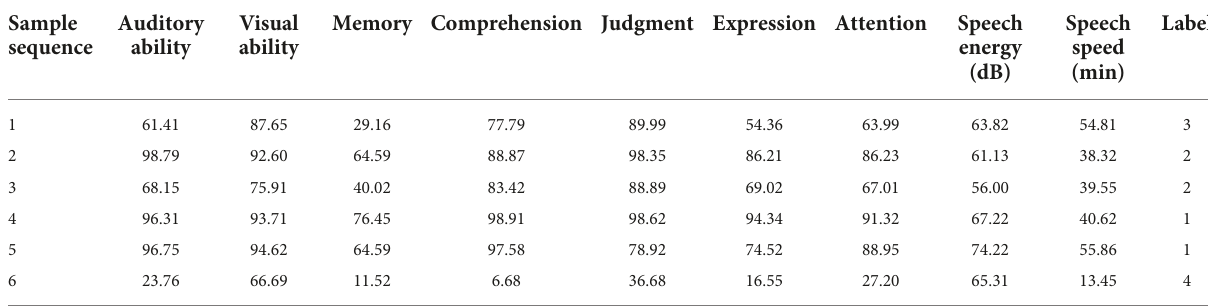
TABLE 5 Data table of foreign language communication ability indicators (%).